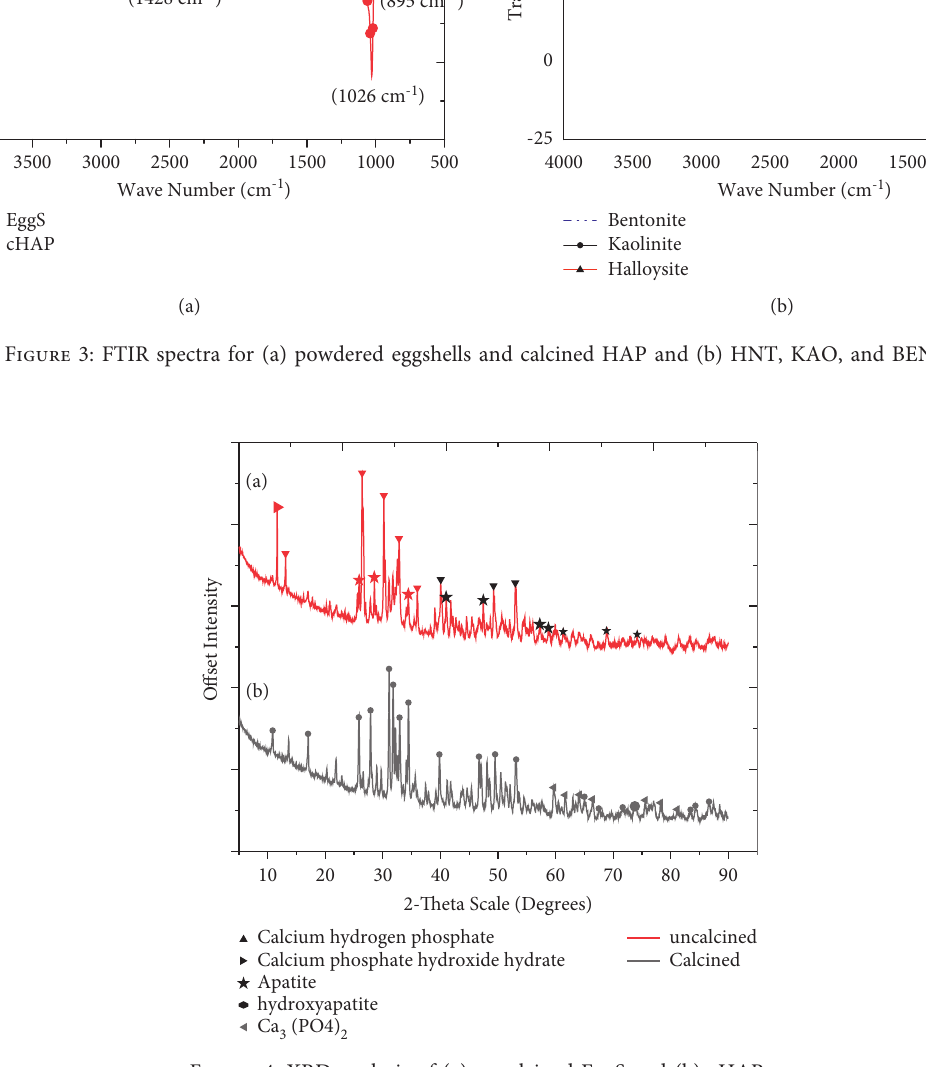
Figure 4: XRD analysis of (a) uncalcined EggS and (b)